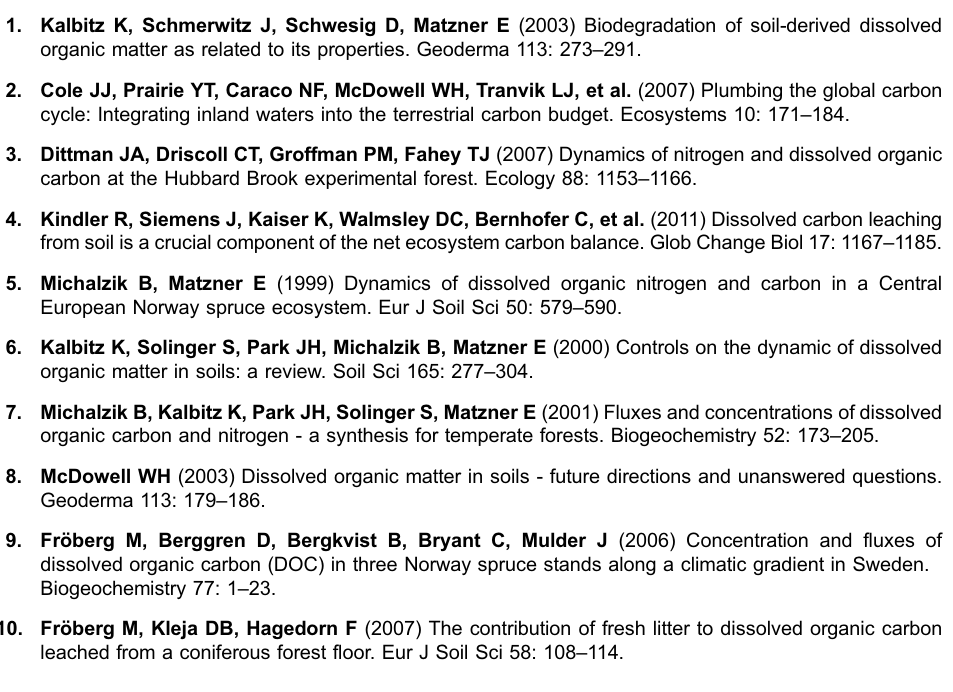
S5 Table. Mean values with lower and higher confidence interval for the measured DOM concentration, d 13 C and conductivity values determined in the soil